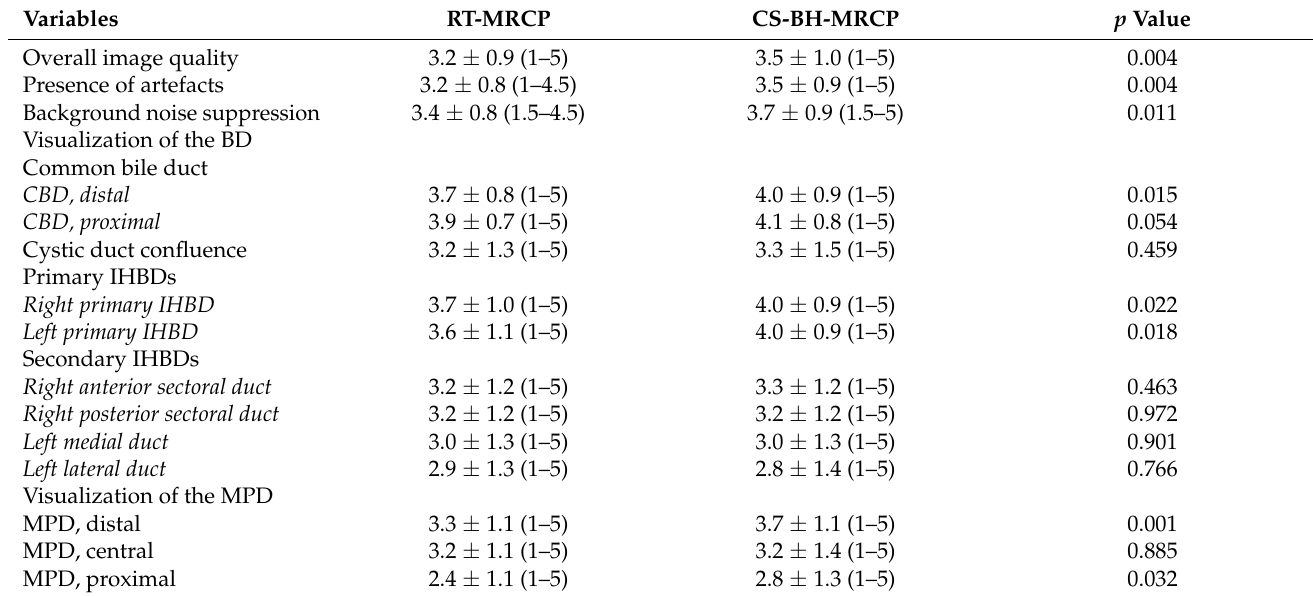
Table 6. Qualitative evaluation: Comparison of the two sequences RT-MRCP and CS-BH-MRCP: mean value [mean ± SD, (range)] of each qualitative variable based a 5-point Likert scale, obtained by the two